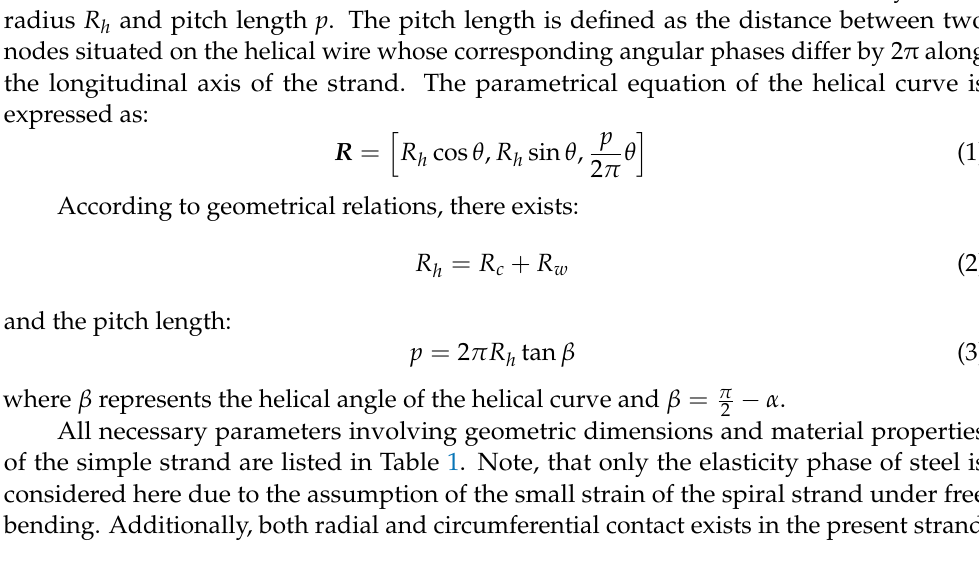
Table 1. Properties of the simple strand.